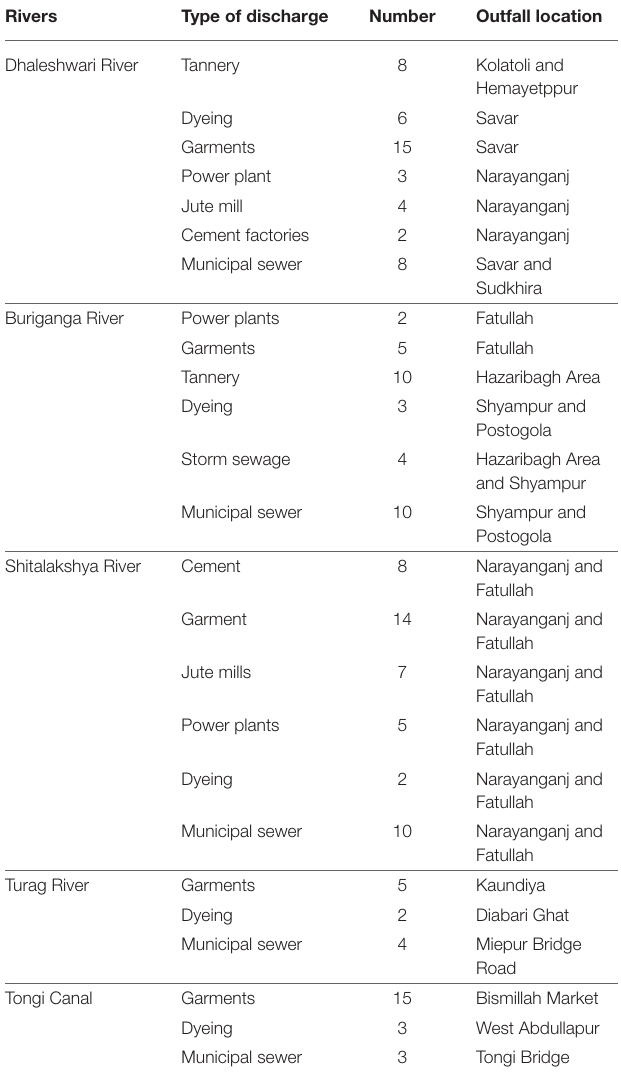
TABLE 1 | Identified outfalls along the river stretches of Dhaka Watershed.